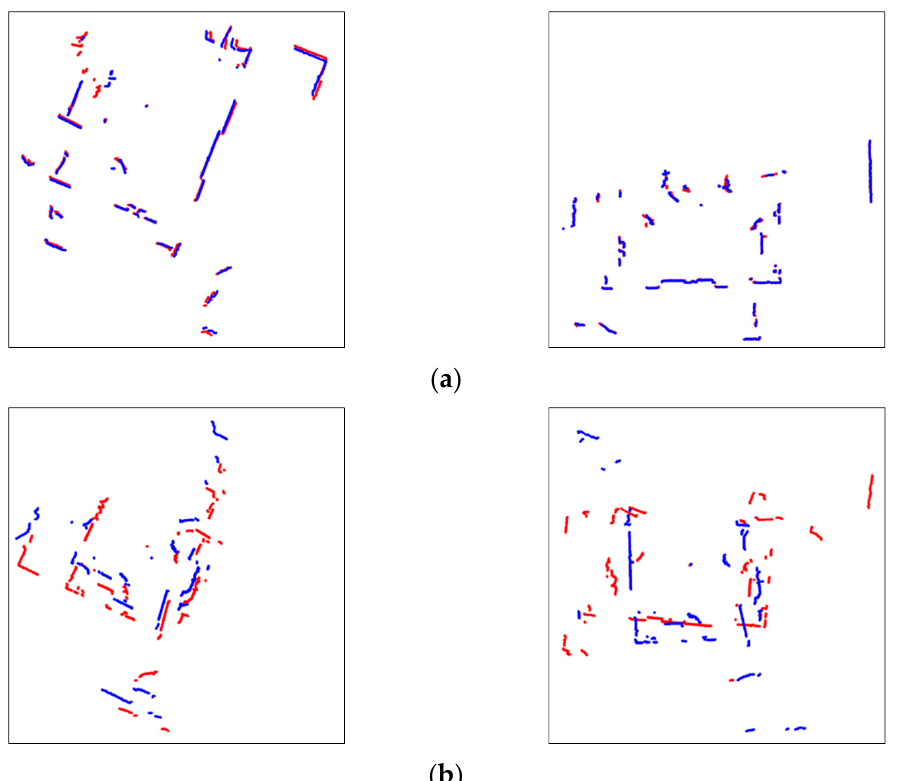
Figure 7. Conversion of scan pairs into images before preprocessing (Red: previous scan, blue: cur- rent scan). The areas where scans are plotted are not fixed. ( a ) t (cid:3404) 𝑡 (cid:2869) ; ( b ) t (cid:3404) 𝑡 (cid:2870) ; ( c ) t (cid:3404) 𝑡 (cid:2871) ; ( d ) t (cid:3404) 𝑡 (cid:2872) .